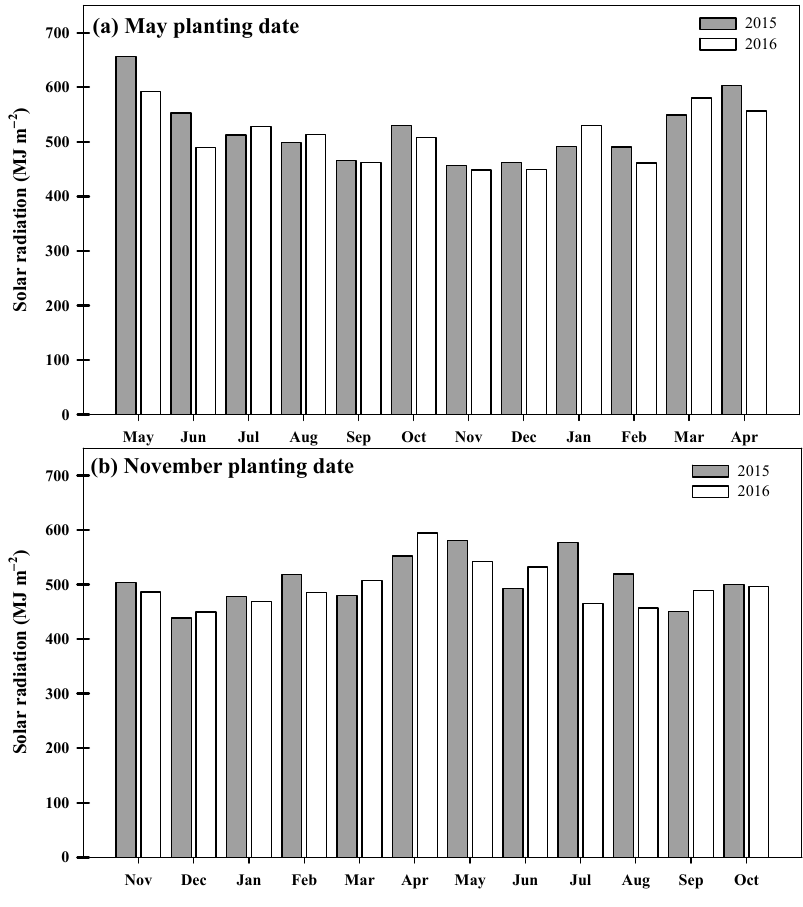
Figure 1. Solar radiation (MJ m − 2 ) in each month during the crop cycle in ( a ) May and ( b ) November in 2015 and 2016.